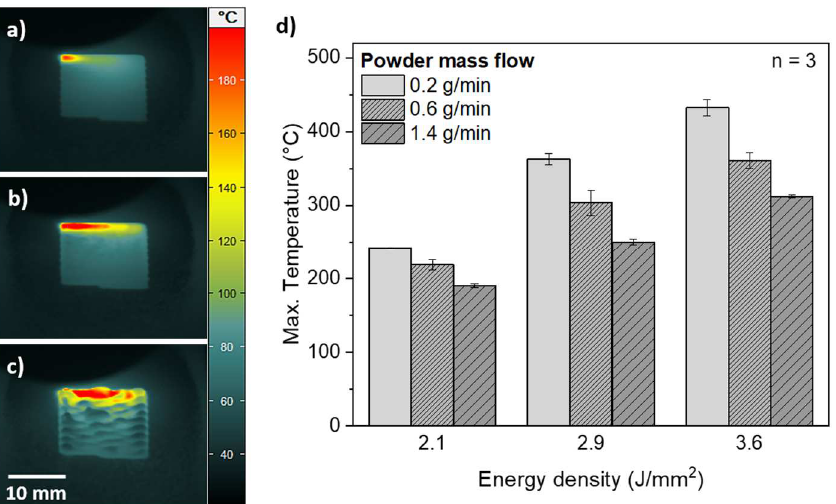
Figure 3. Color-coded thermographic mappings of PA12 coatings deposited by a powder mass flow of 0.6 g/min for energy densities of ( a ) 2.1 J/mm 2 , ( b ) 2.9 J/mm 2 and ( c ) 3.6 J/mm 2 . The maximum temperatures during DED-LB/P processing as a function of the energy density and powder mass flow ( n = 3) are shown in ( d ) (emission coefficient set to 0.98).